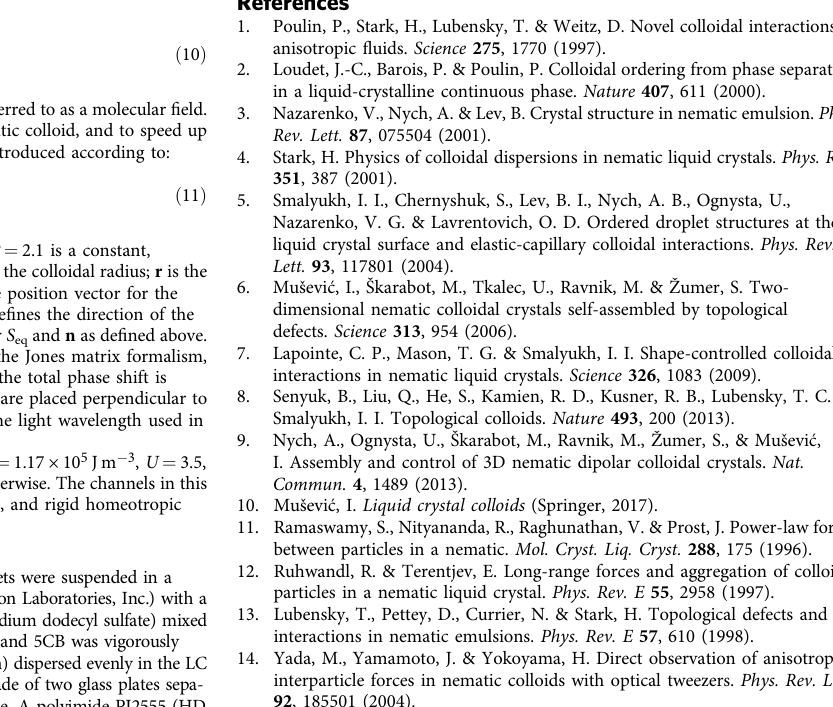
Figure 5d illustrates the distinction between these expressions; degenerate conic anchoring (Eq. (5)) imposes a lesser energy penalty for deviations of the directors from their preferred direction than Eqs. (3) and (4). An iterative Ginzburg-Landau relaxation (Eq. (10)) with fi nite differences on a cubic mesh of 7.15 nm is applied here to minimize the total free energy 35 (see detailed equations in SI): d Q ij ð Γ 10 Þ where Γ is a numerical relaxation constant and h ij is referred to as a molecular fi eld. In order to ensure the formation of a dipolar nematic colloid, and to speed up the relaxation process, a speci fi c initial condition is introduced according to: